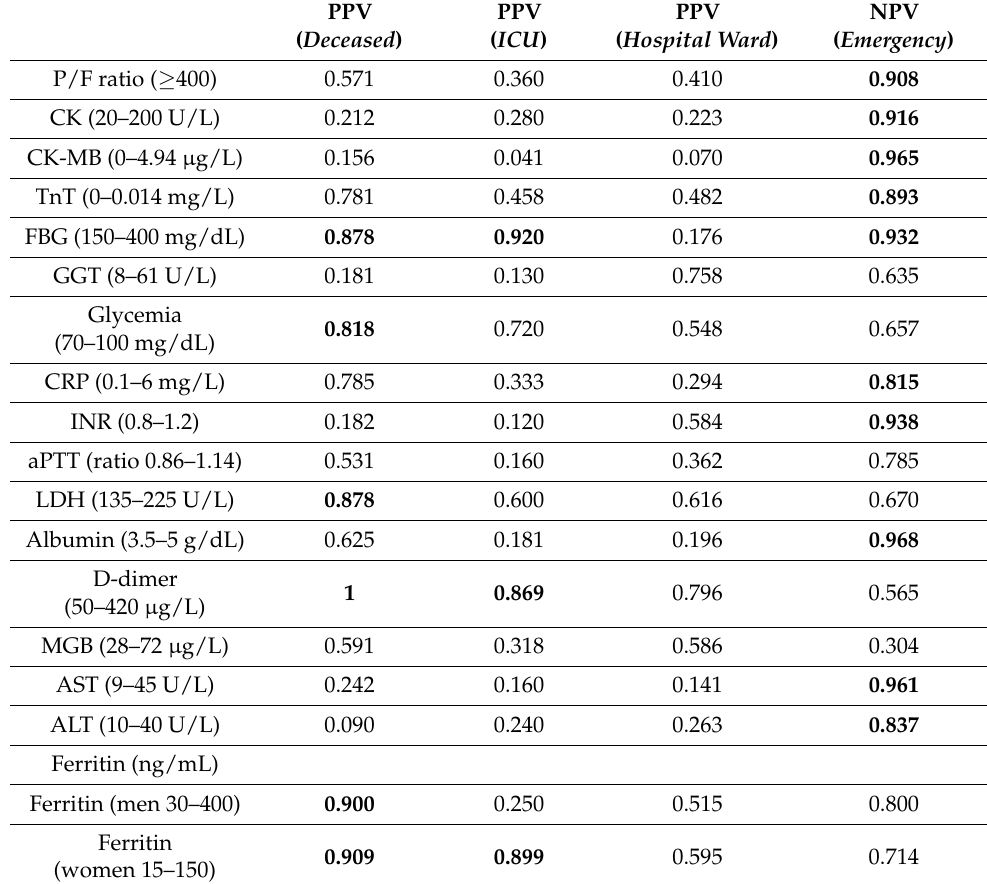
Table 6. Positive predictive values (PPV—probability that the patient has the condition when restricted to those patients who test positive) in the deceased , ICU and hospital ward groups and negative predictive values (NPV—probability that a patient who has a negative test result indeed does not have the condition) in the emergency group are based on the reference values (out of range for PPV; in range for NPV) for P/F ratio, CK, CK-MB, TNT, FBG, GGT, glycemia, CRP, INR, aPTT, LDH, albumin, D-dimer, MGB, AST, ALT, and ferritin (men and women—see Section 2). Significant scores are shown in bold. PPV PPV PPV NPV ( Deceased ) ( ICU ) ( Hospital Ward ) ( Emergency ) P/F ratio ( ≥ 400) 0.571 0.360 0.410 0.908